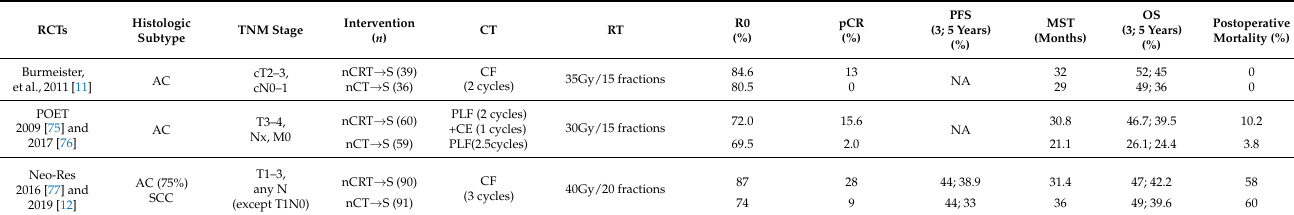
Table 5. Clinical trials of neoadjuvant chemoradiotherapy versus chemotherapy for locally advanced resectable EC.